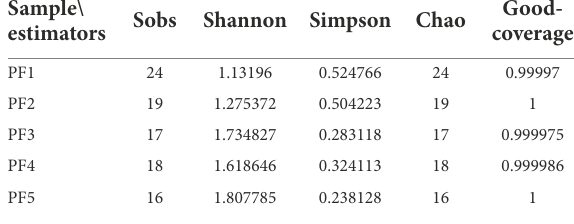
TABLE 1 Alpha diversity index.